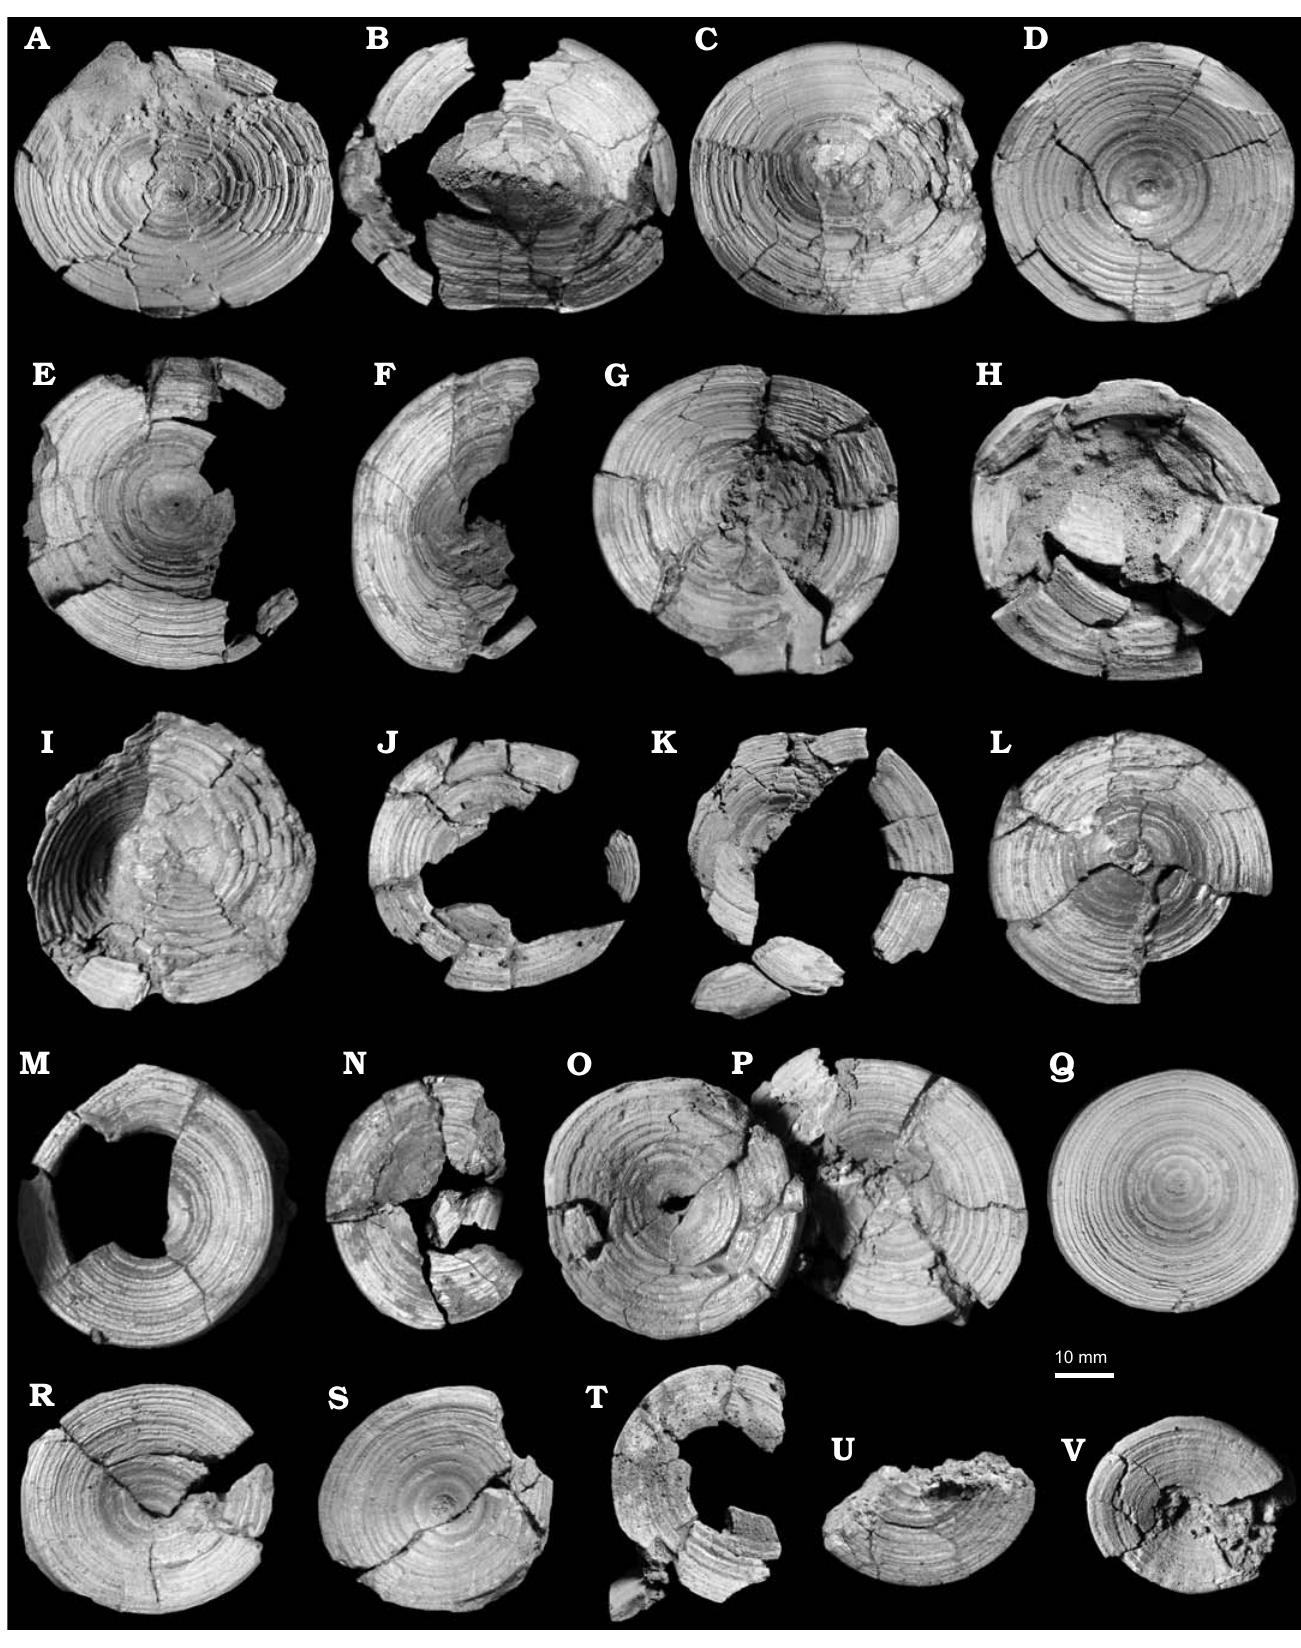
Fig. 6. Trunk and precaudal vertebrae of the mackerel shark Carcharomodus escheri (Agassiz, 1843), MNU 071-20, from Groß Pampau, the middle–late Miocene, from anterior ( A ) to posterior ( V